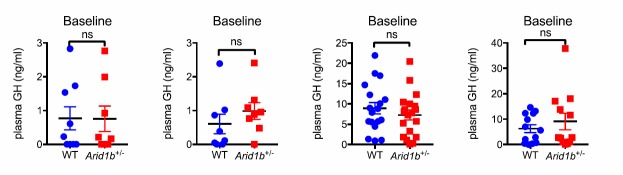
DOI:
http://dx.doi.org/10.7554/eLife.25730.022